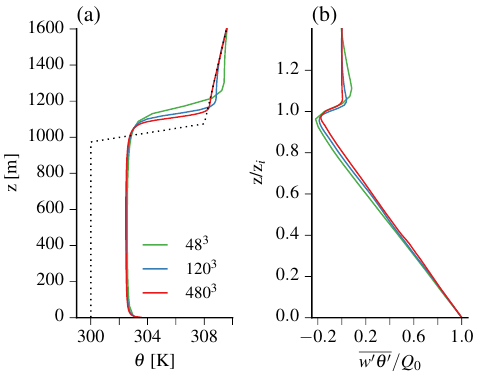
Figure 9. Vertical profiles of horizontally averaged potential tem- perature (a) and normalized kinematic heat flux (b) . The boundary layer depth z i is the location of the maximum vertical gradient in the potential temperature profile shown in (a)